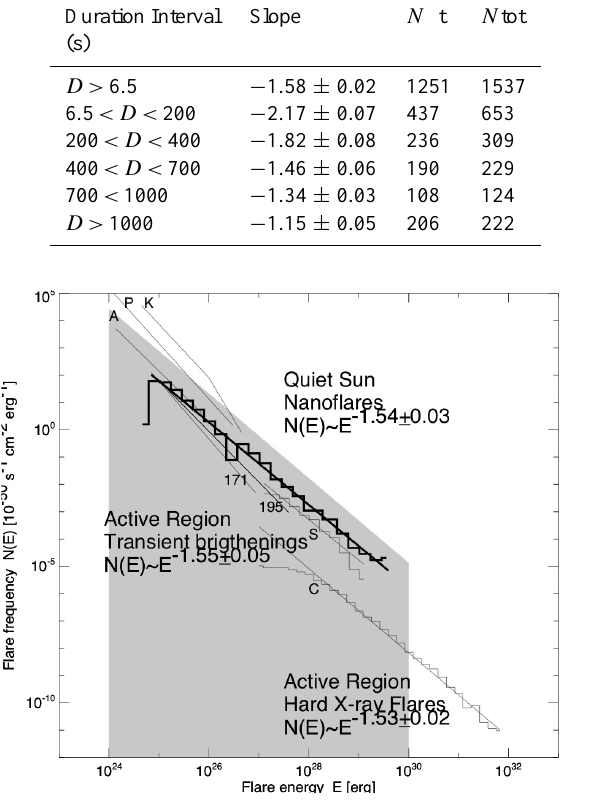
Fig. 2. Compilation of frequency distributions of thermal en- ergies from nanoflare statistics in the quiet Sun, active region transient brightenings, and hard X-ray flares. The labels in- dicate the following studies: K = Krucker and Benz (1998), Benz and Krucker (2002), P = Parnell and Jupp (2000) (cor- rected for an error in the original paper), A = Aschwanden et al. (2000), Shimizu (1995), C = Crosby et al. (1993), and 171, 195 = Aschwanden and Parnell (2002). From Aschwanden